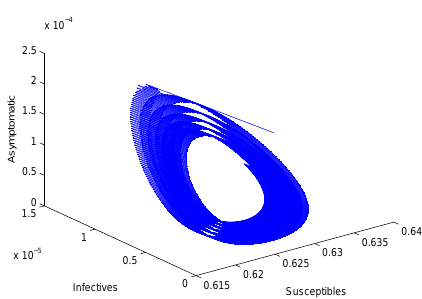
Fig. 2: Damped oscillations approaching the en- demic equilibrium, γ = γ (3 , 7) , (cid:60) = 1 . 7 , p = 0 . 2 , σ = 0 . 2 , β = 0 . 6 , and 0 k ≥ 3 .